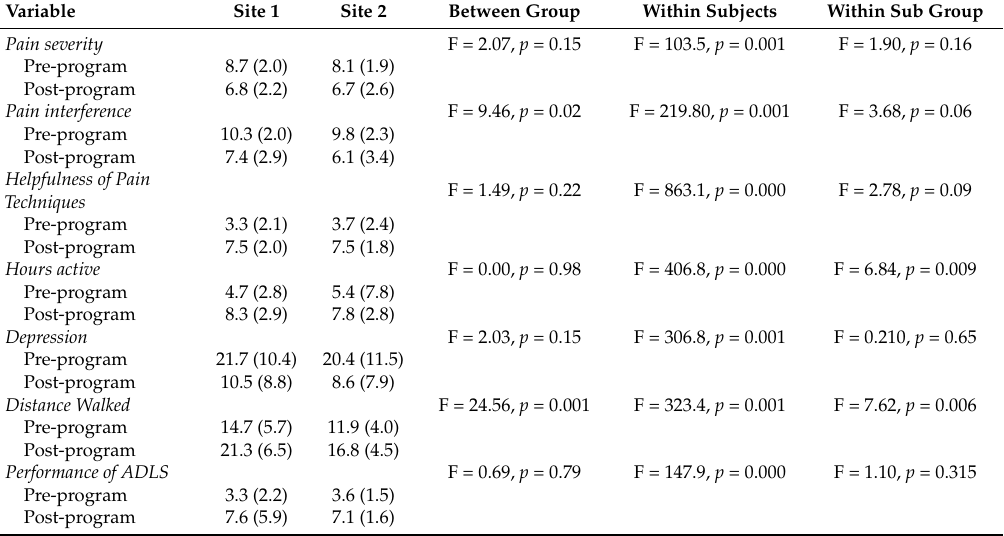
Table 5. Changes in outcome variables with 95% confidence intervals for both groups (program sites), within subjects (pre/post differences for combined sites), and interaction of group (program site by within